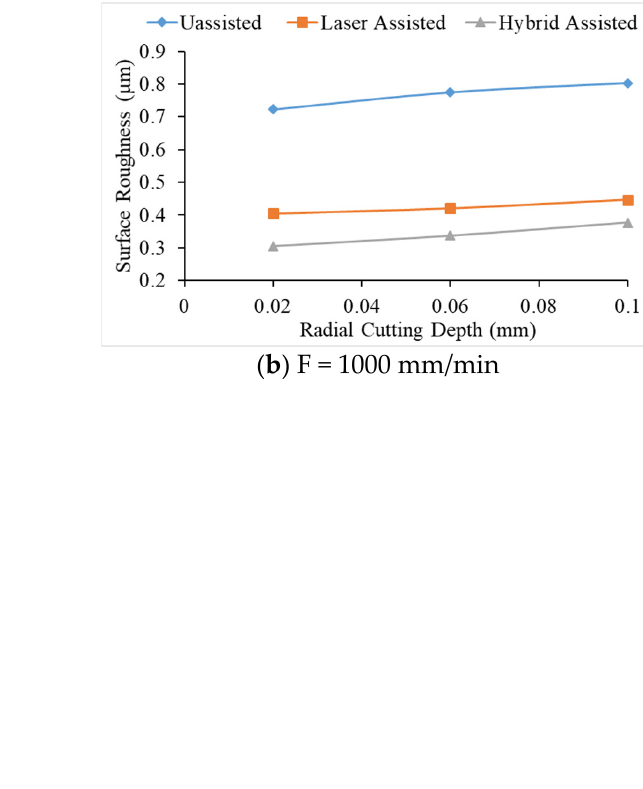
Figure 5. The relationship between radial depth of cutting and surface roughness under different feeds for unassisted, laser-assisted, and hybrid-assisted systems.